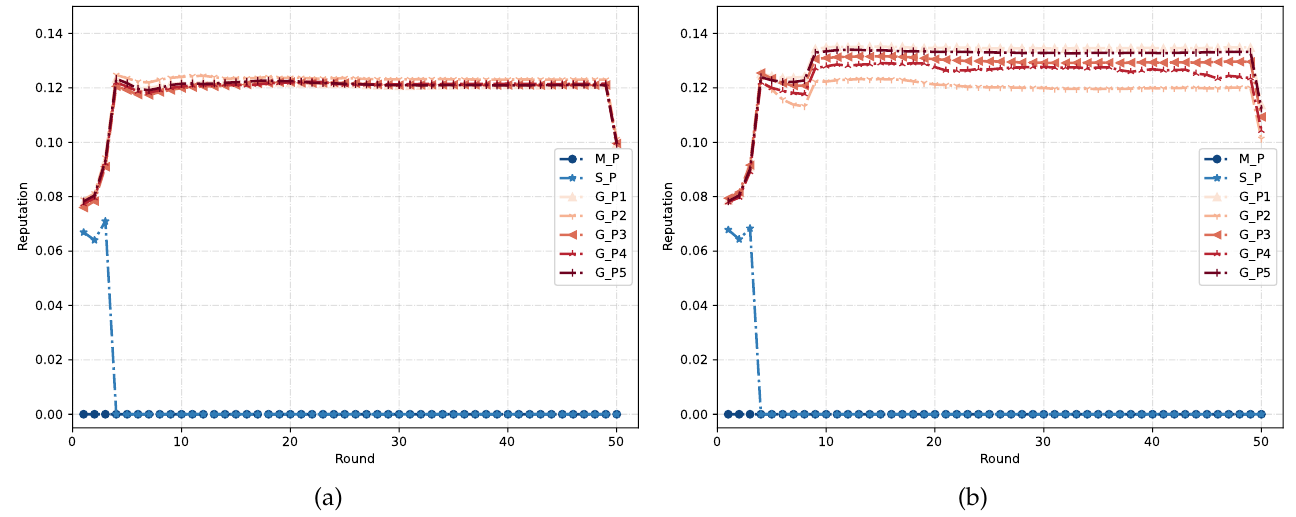
Figure 2. Reputations of the participants. ( a ) Participants’ reputations under UNI split MNIST. ( b ) Participants’ reputations under POW split MNIST.